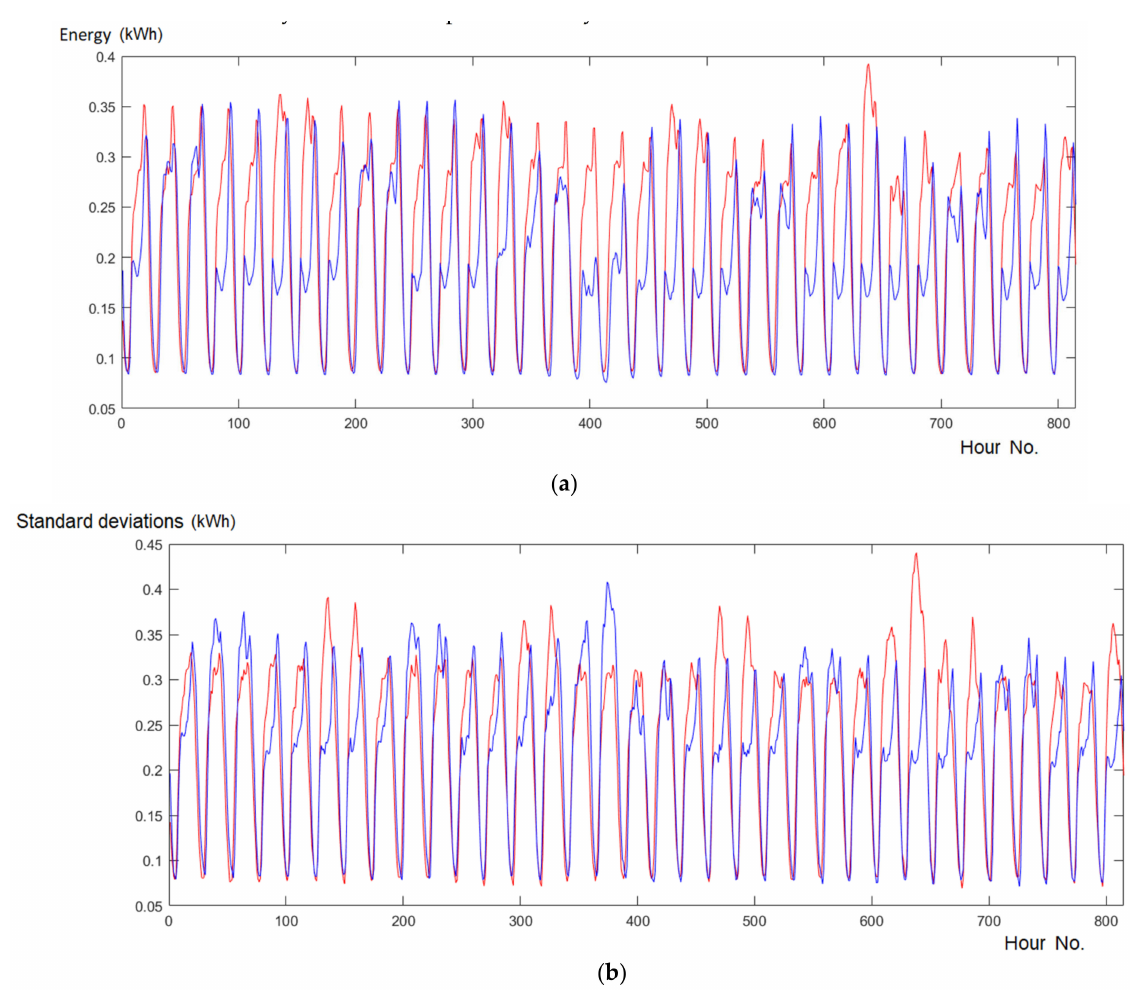
Figure 13. Graphs of the average active energy consumption ( a ) and standard deviations ( b ) in the group of analysed dwellings over 815 h during the lockdown in 2020 (red lines) and in 2018 (blue